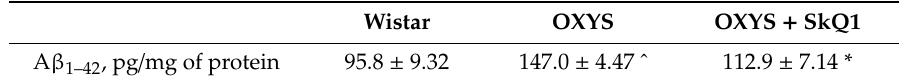
Table 1. The influence of supplementation with SkQ1 on A β 1–42 concentration in the hippocampus of OXYS